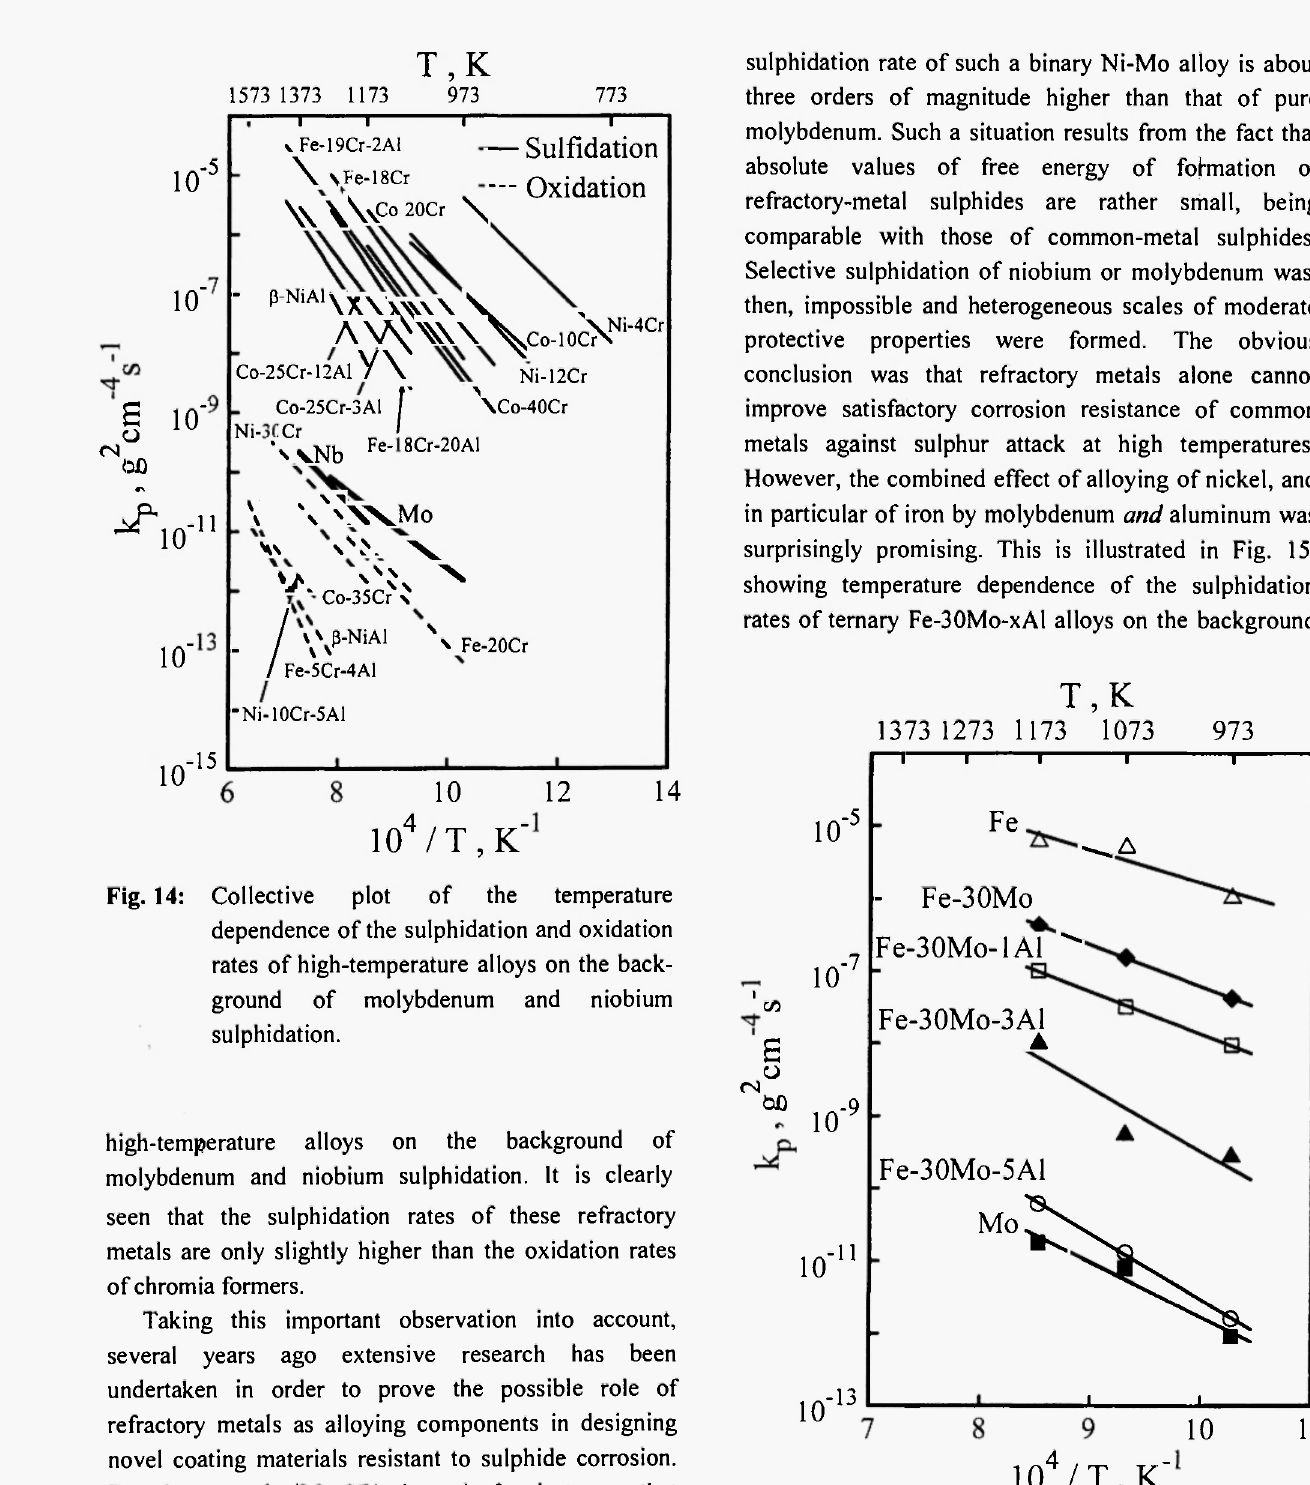
Temperature dependence of the sulphidation rate of Fe-30Mo and Fe-30Mo-xAl alloys compared to the sulphidation rates of pure iron and